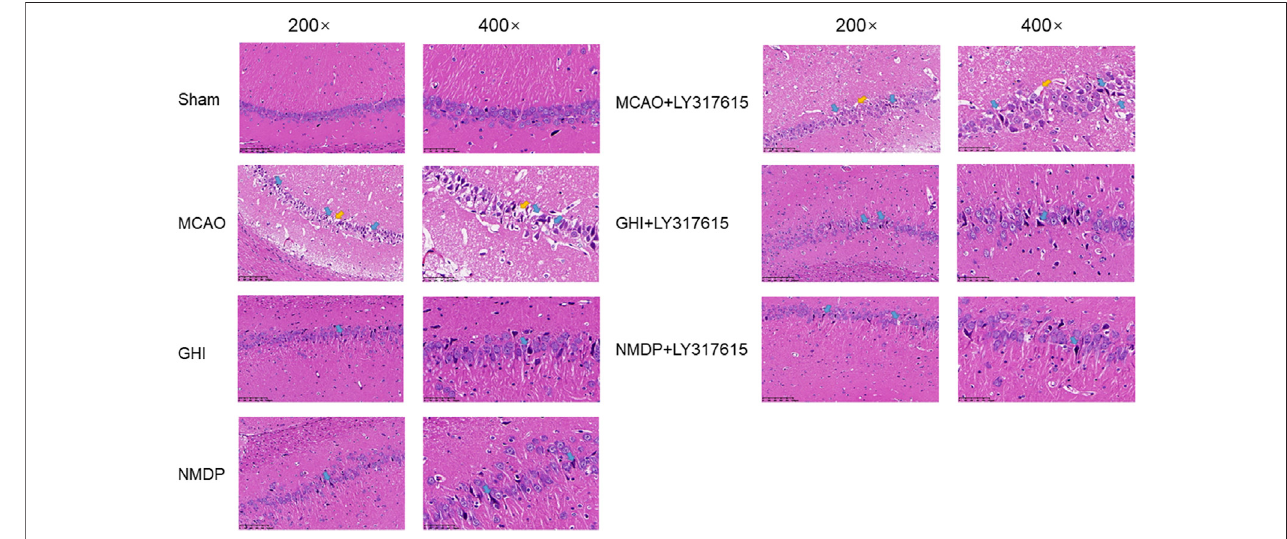
FIGURE 5 | HE staining in the hippocampal for each group.